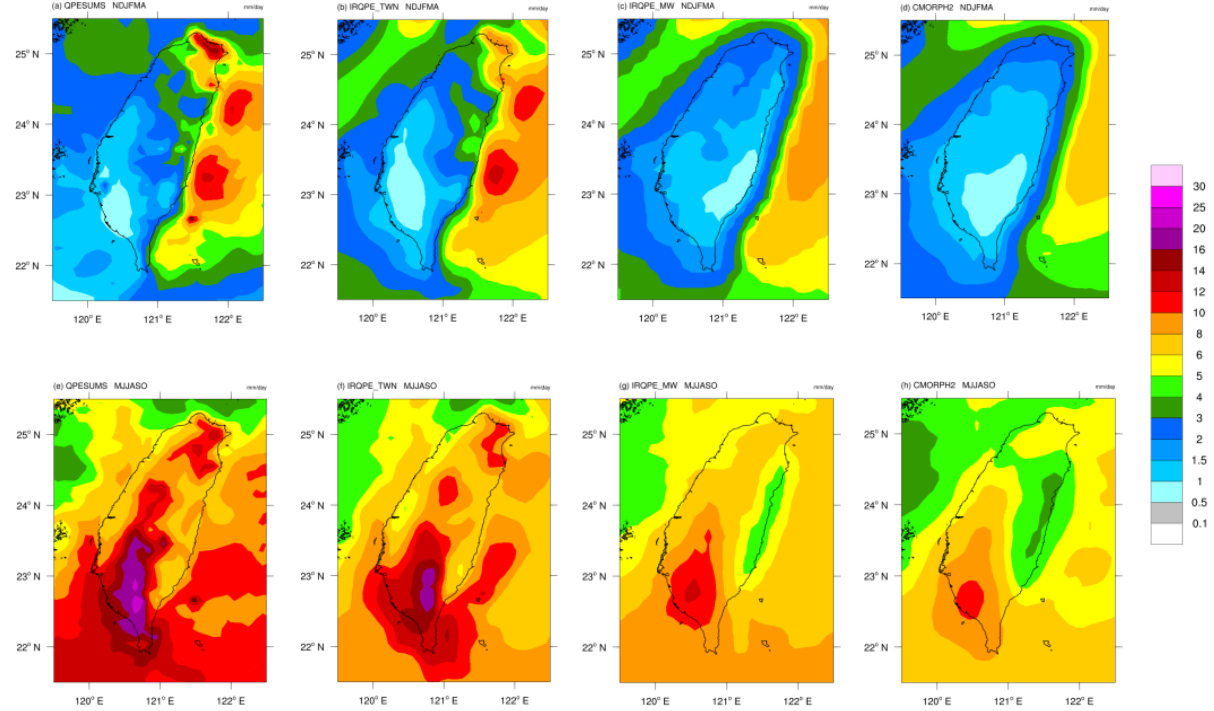
Figure 11. The 4-year mean rain map over Taiwan area for (top) cold season (NDJFMA) and (bottom) warm season (MJJASO). ( a , e ) QPESUMS, ( b , f ) IRQPE_TWN, ( c , g ) IRQPE_MW, ( d , h ) CMORPH2.